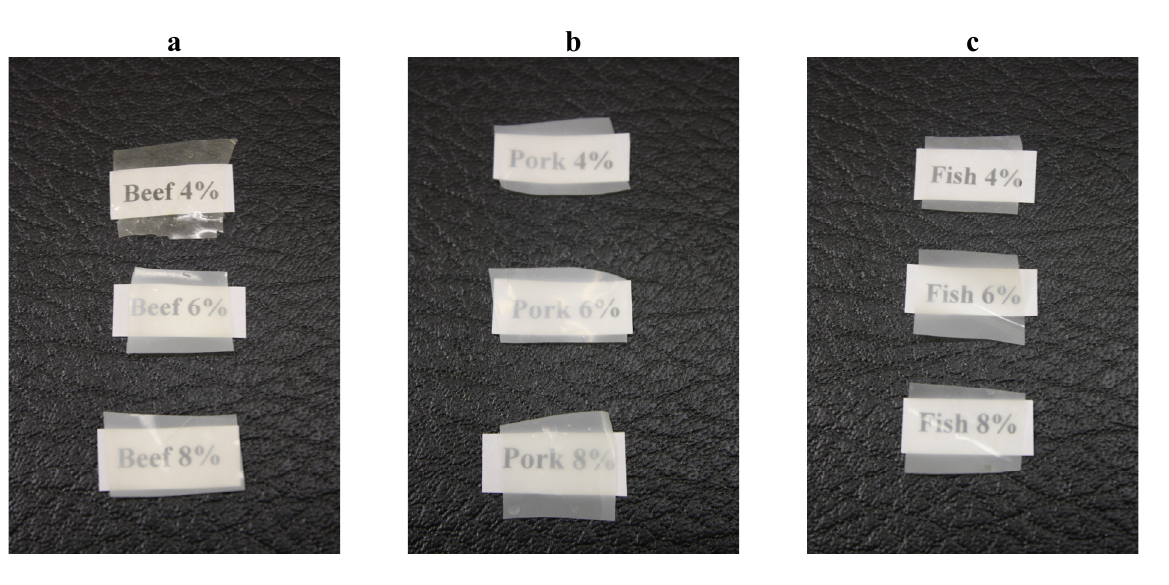
Figure 2. Films manufactured from gelatin derived from ( a ) beef, ( b ) pork and ( c ) fish sources with the concentrations of 4%, 6% and